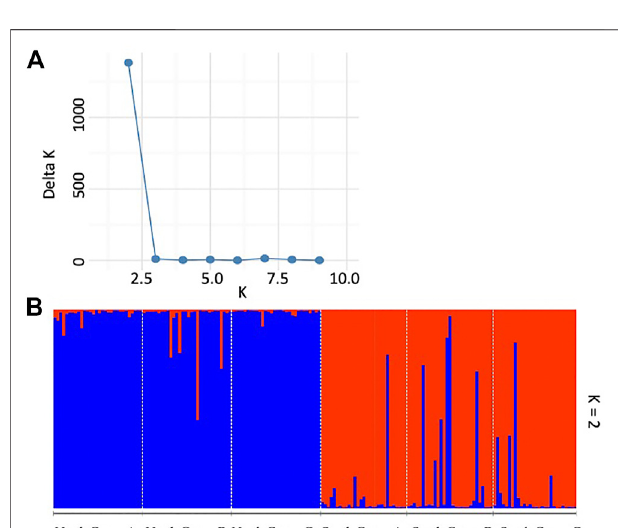
FIGURE 3 | Bayesian clustering using STRUCTURE for the Pyrus calleryana dataset. Results were analyzed using (A) the Evanno method and visualized using (B) two (K = 2) inferred genetic clusters. An individual sample is representedbyeach verticalbar and anindividual ’ sprobabilitytobelong to the identi fi ed cluster is represented by the blue versus red bar